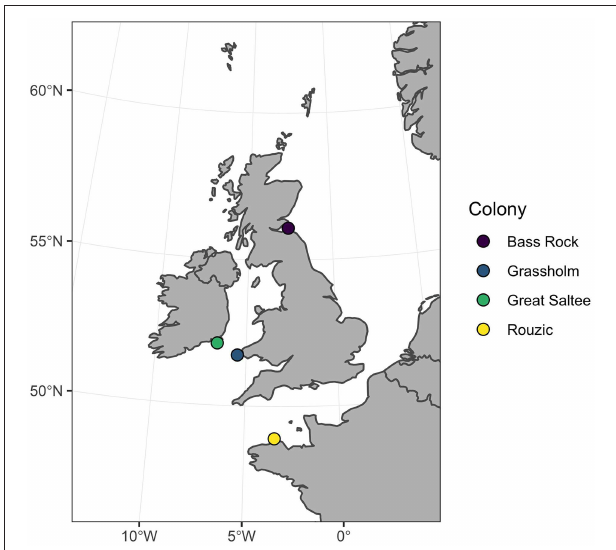
FIGURE 1 | Location of the four northern gannet study colonies across the UK, Ireland and France.